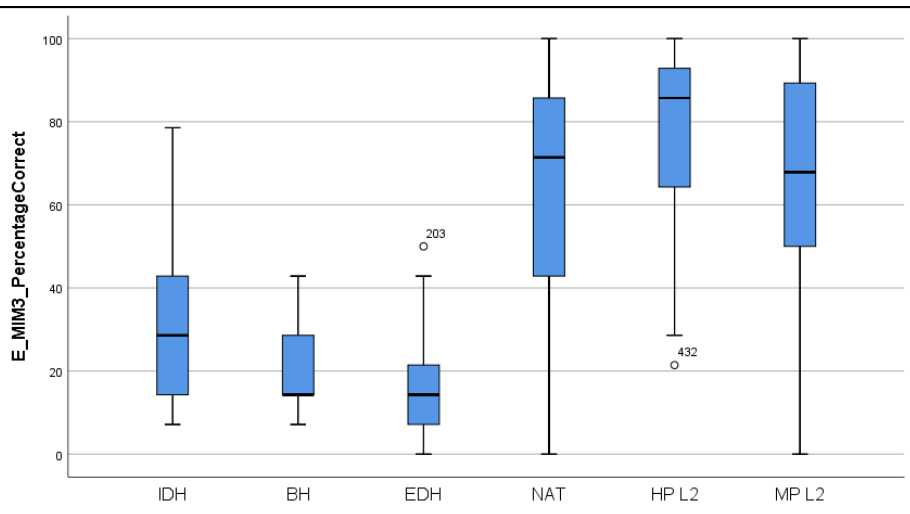
Figure 5. E-MIM Subtest 3 (third-person possession): Accuracy of child and adult participants by language background, IDH = Child, Irish-Dominant Home; BH = Child, Bilingual Home; EDH = Child, English-Dominant Home; NAT = Adult L1/Native Speaker; HP L2 = Adult Highly Proficient L2 speaker; MP L2 = Adult Moderately Proficient L2 speaker.